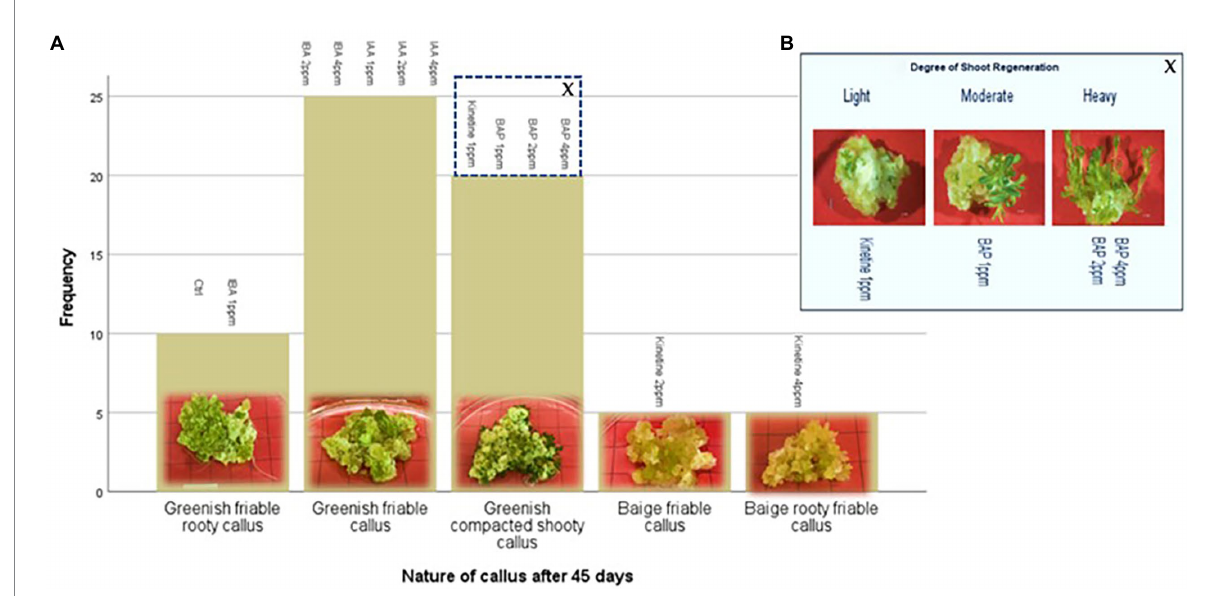
FIGURE 2 Indirect regeneration of shoots; (A) Nature of callus after 45 days on regeneration media, (B) Degree of shoot regeneration. Each treatment was replicated 10